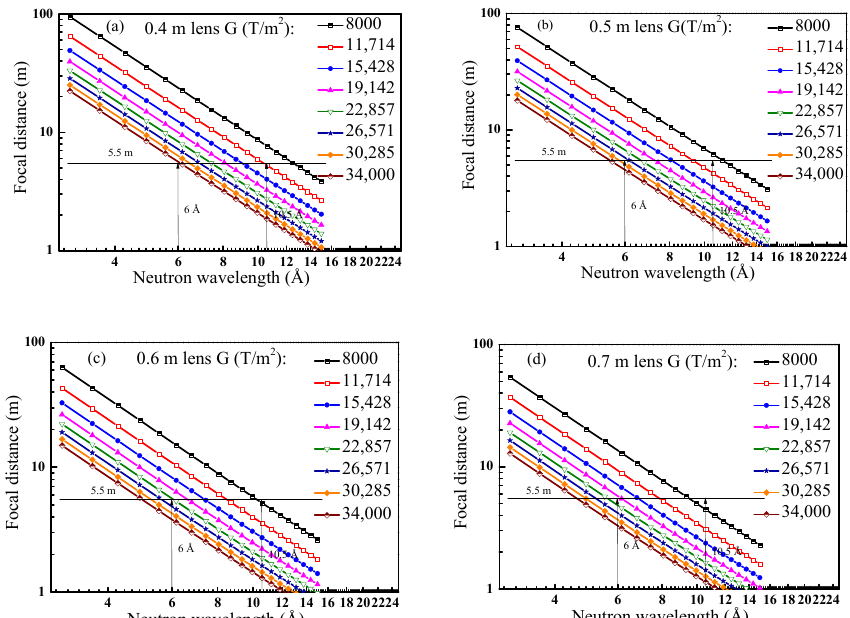
Figure 5. The theoretical maximum and minimum magnetic field gradients required to focus neutrons from 6 angstroms to 10.5 angstroms when the length of the magnetic lens is ( a ) 0.4 m, ( b ) 0.5 m, ( c ) 0.6 m, and ( d ) 0.7 m.